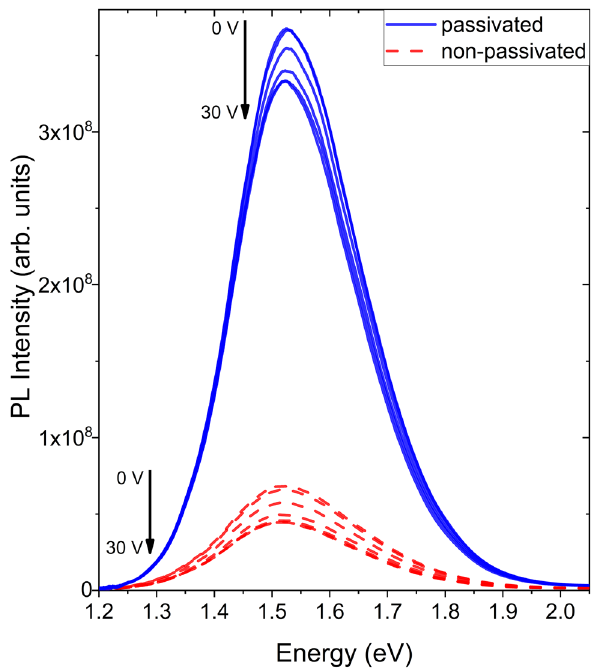
Figure 3. PL spectra as a function of applied voltages (0–30 V, in steps of 5 V) of a passivated and a non- passivated sample with barrier oxide thicknesses of 2 nm measured at RT.